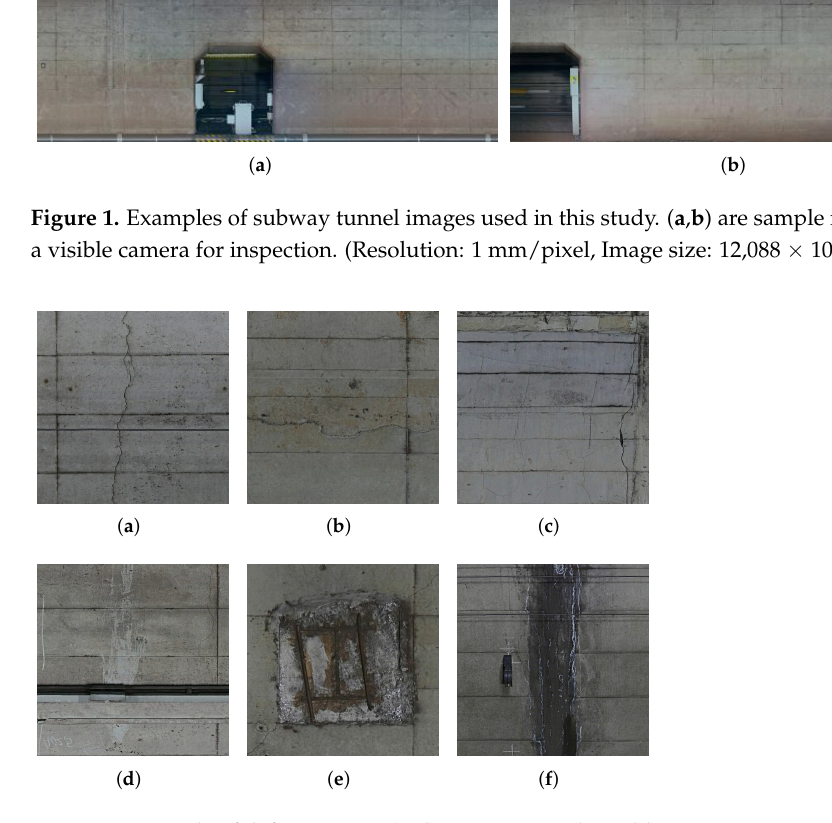
Figure 2. Example of defect images. ( a – f ) represent cracks, cold joint, construction repair, deposition, peeling, and trace of water leakage, respectively. (Resolution: 1 mm/pixel, Image size: 256 × 256